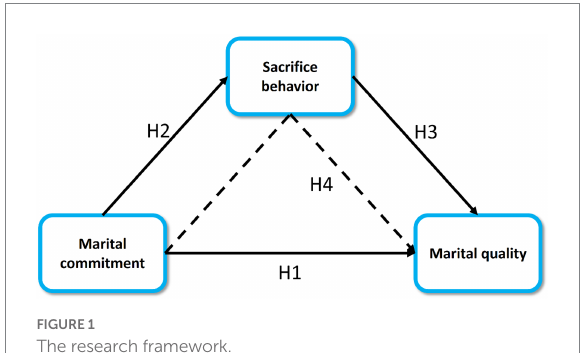
FIGURE 1 The research